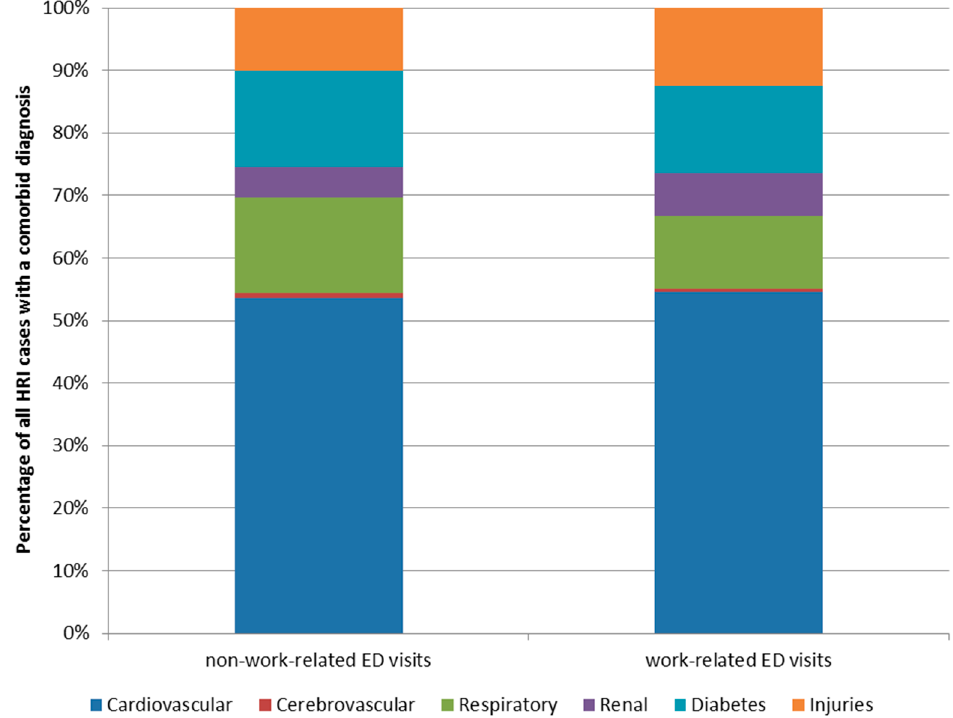
Figure 5. Distribution of co-morbid outcomes among Florida residents identified with HRI in the ED, stratified by work-related status (2005–2012).